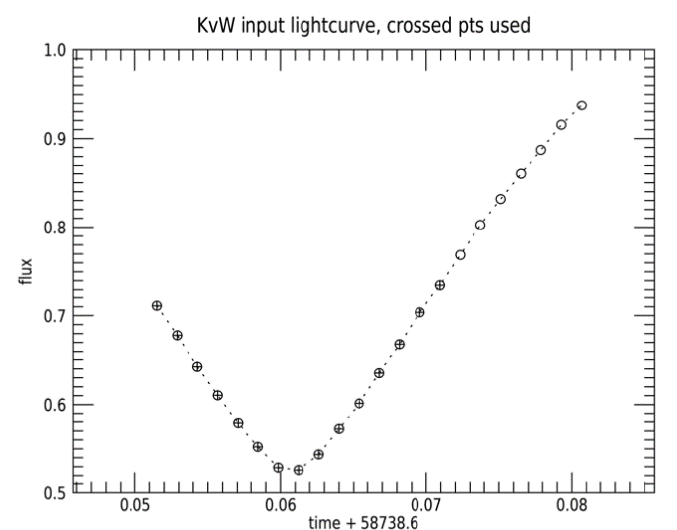
Figure 3. Input light curve for the KvW algorithm of the first—but incomplete—CM Dra eclipse in TESS data, which is a primary eclipse at BJD 2458738.6607. The y axis represents the normalized flux and the x axis indicates BJD-2400000. The code selects the maximum amount of data points that can be paired for folds (filled circles) and ignores the others (open circles). When numbering the points by counting from zero, the eclipse minimum is between points 6 and 7 (see the ‘fold-ID’ in Figure 4).